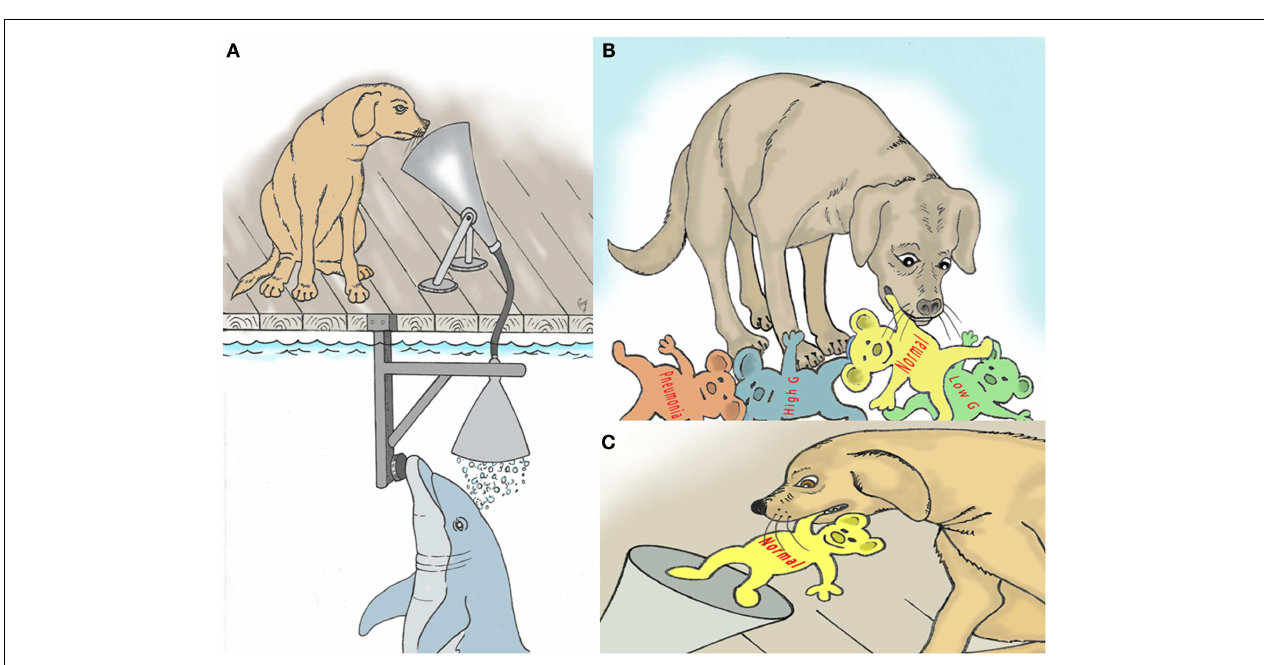
FIGURE 2 | (A) Depiction of trained dog sniffing dolphin breath for assessment of metabolic and disease markers. (B) Dog selects named models that represent various breath markers of metabolism and disease. (C) The selected model is deposited back into the “sniff” funnel to confirm the dog’s decision.